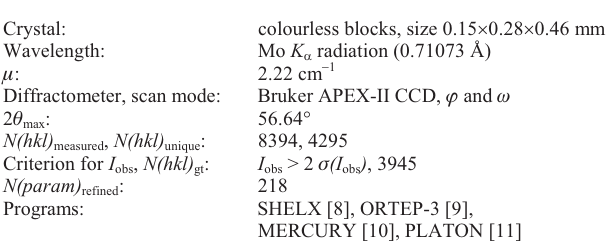
Table 1. Data collection and handling.